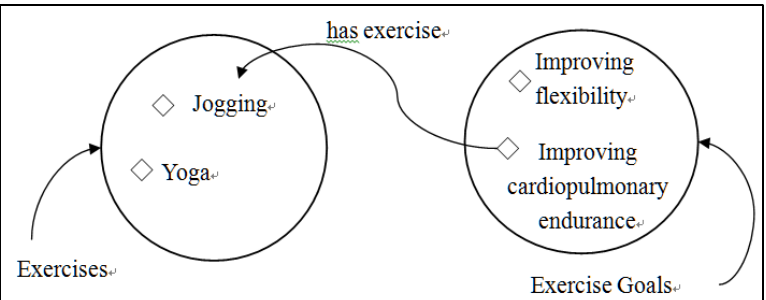
Figure 5. Class-Property-Instance example of